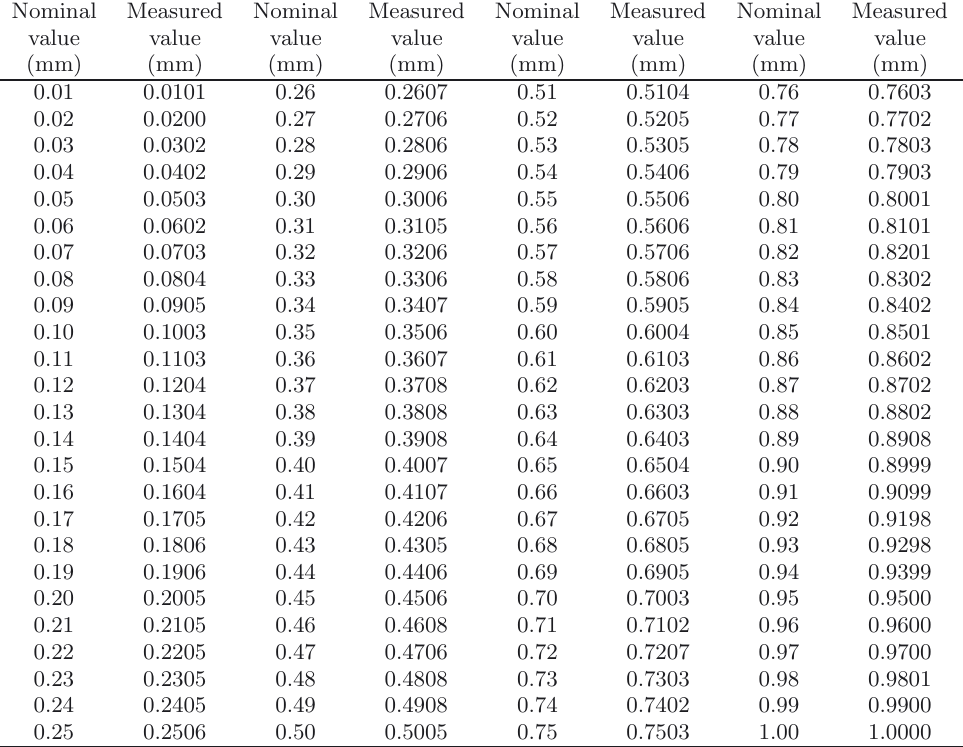
Table 2. Results obtained for the lengths of the 1 mm scale.